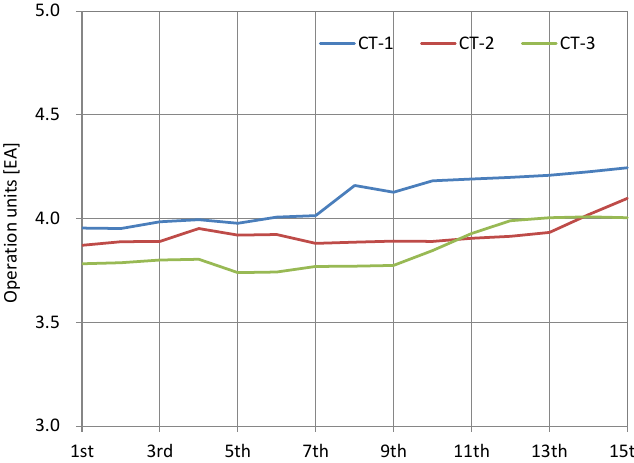
Figure 11. Changes in the annual average number of cooling tower fans.